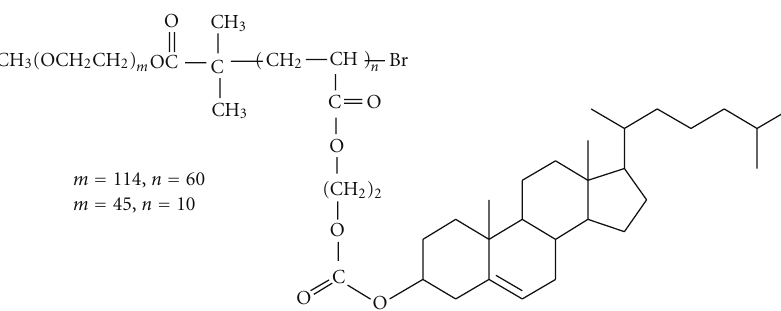
Figure 9: Chemical structure of amphiphilic block copolymers containing a Chol-based